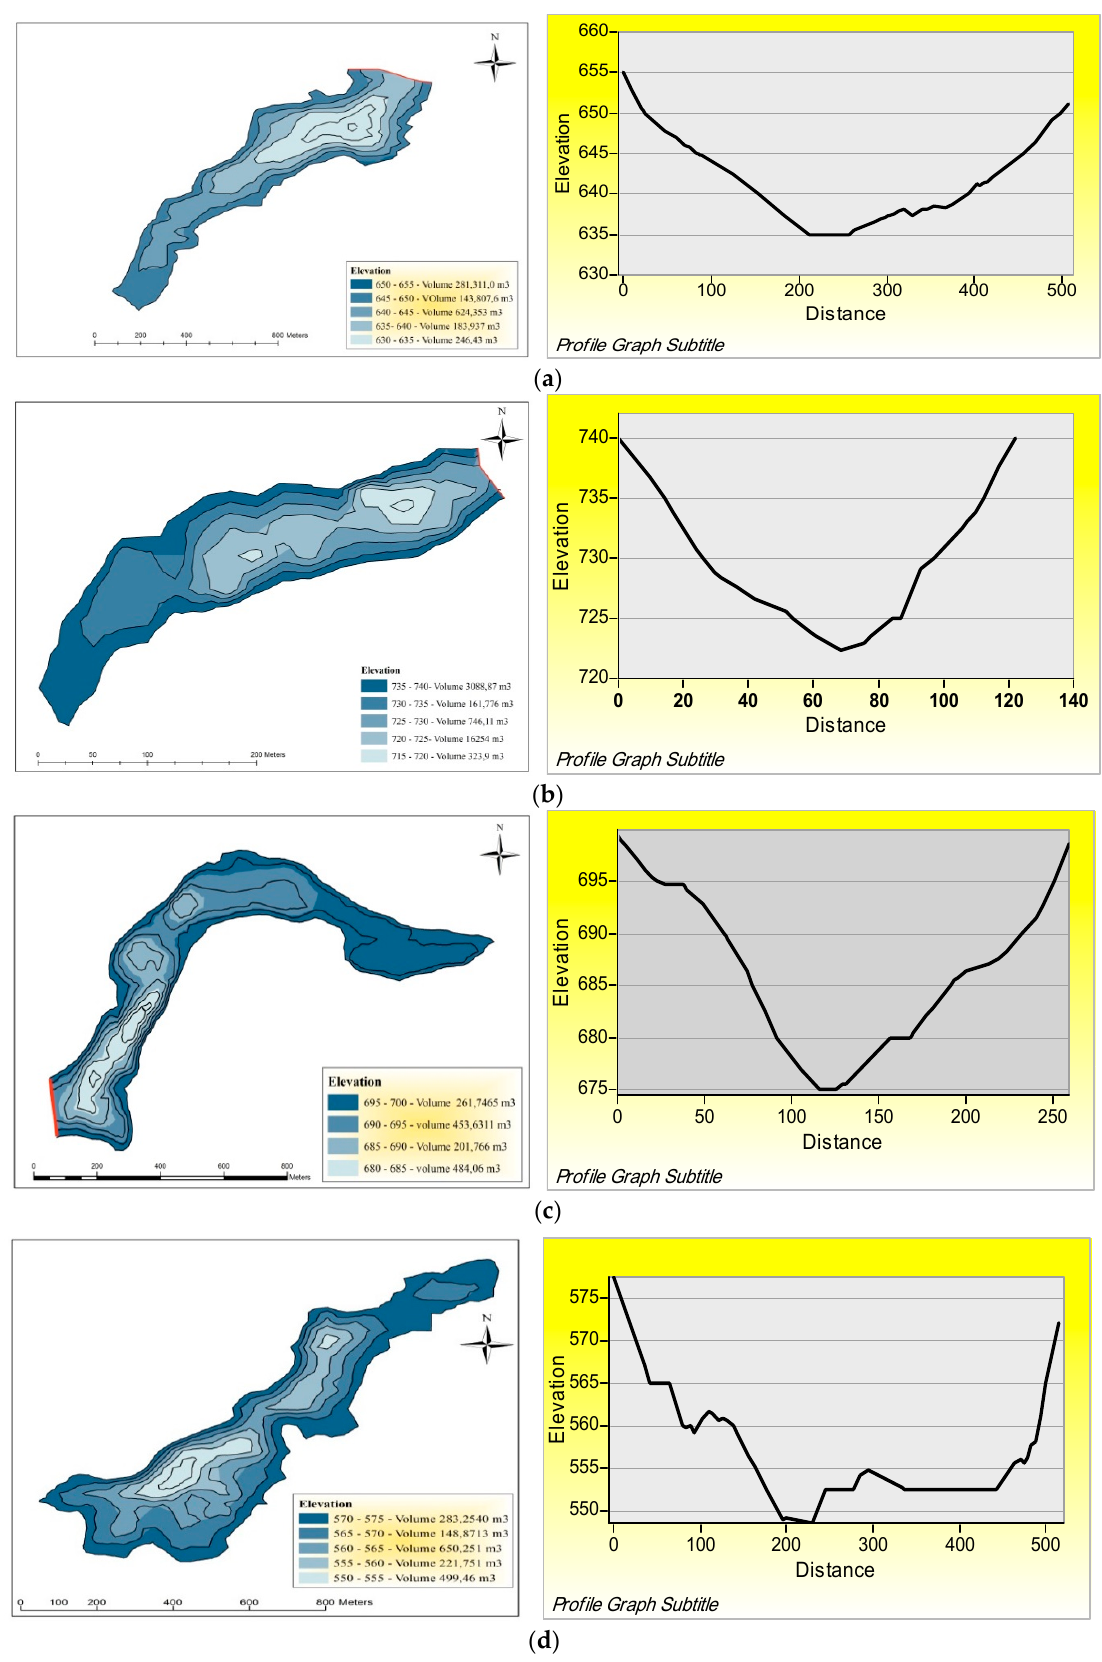
Figure 7. The storage capacity of the dams in the study site. ( a ) dam 1, ( b ) dam 2, ( c ) dam 3 and ( d ) dam 4.